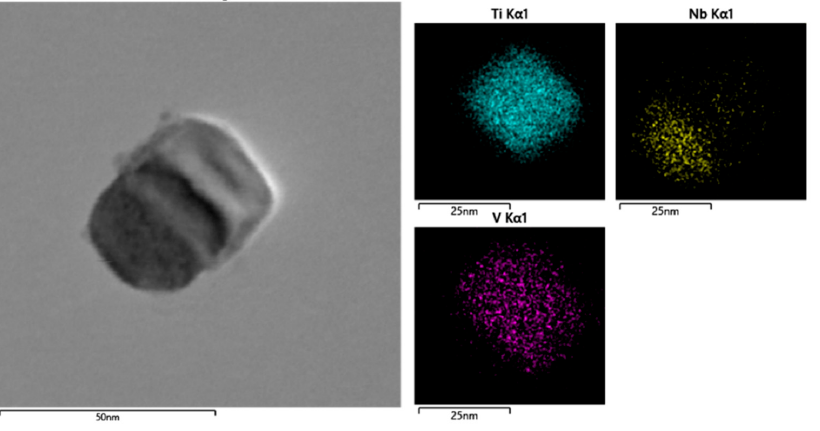
Figure 4. Morphology and corresponding composition distribution of Nb/V/Ti in a random precipitate in Figure 2b.